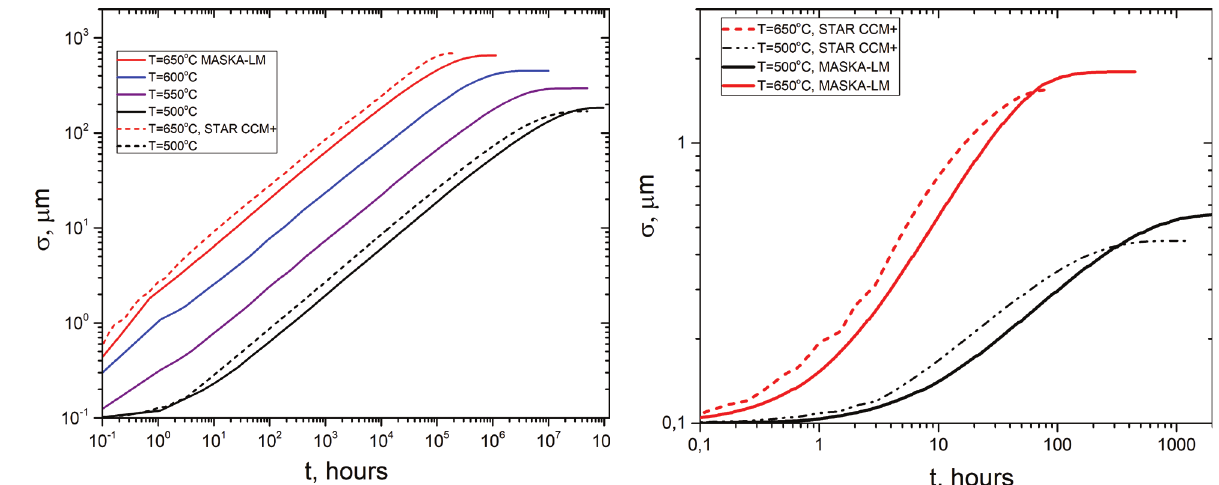
Figure 17. The results of calculations of film growth carried out in the framework of MASKA-LM, STAR-CCM+ at tem - peratures T=650 o C and Т=500 о С. Mass oxygen content is – 10 -8 kg/kg. The curves are trimmed after the thickness of the films reaches the saturation